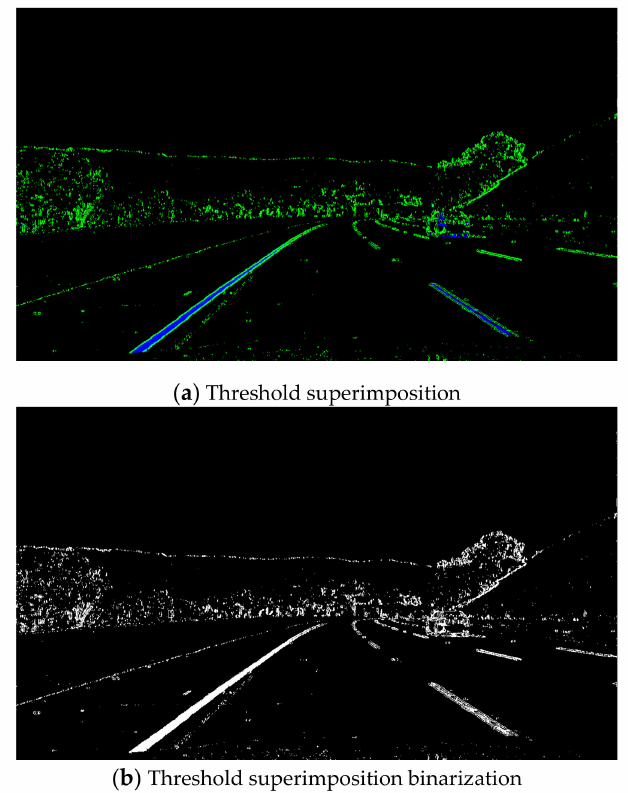
Figure 5. Gradient threshold and colour threshold superposition